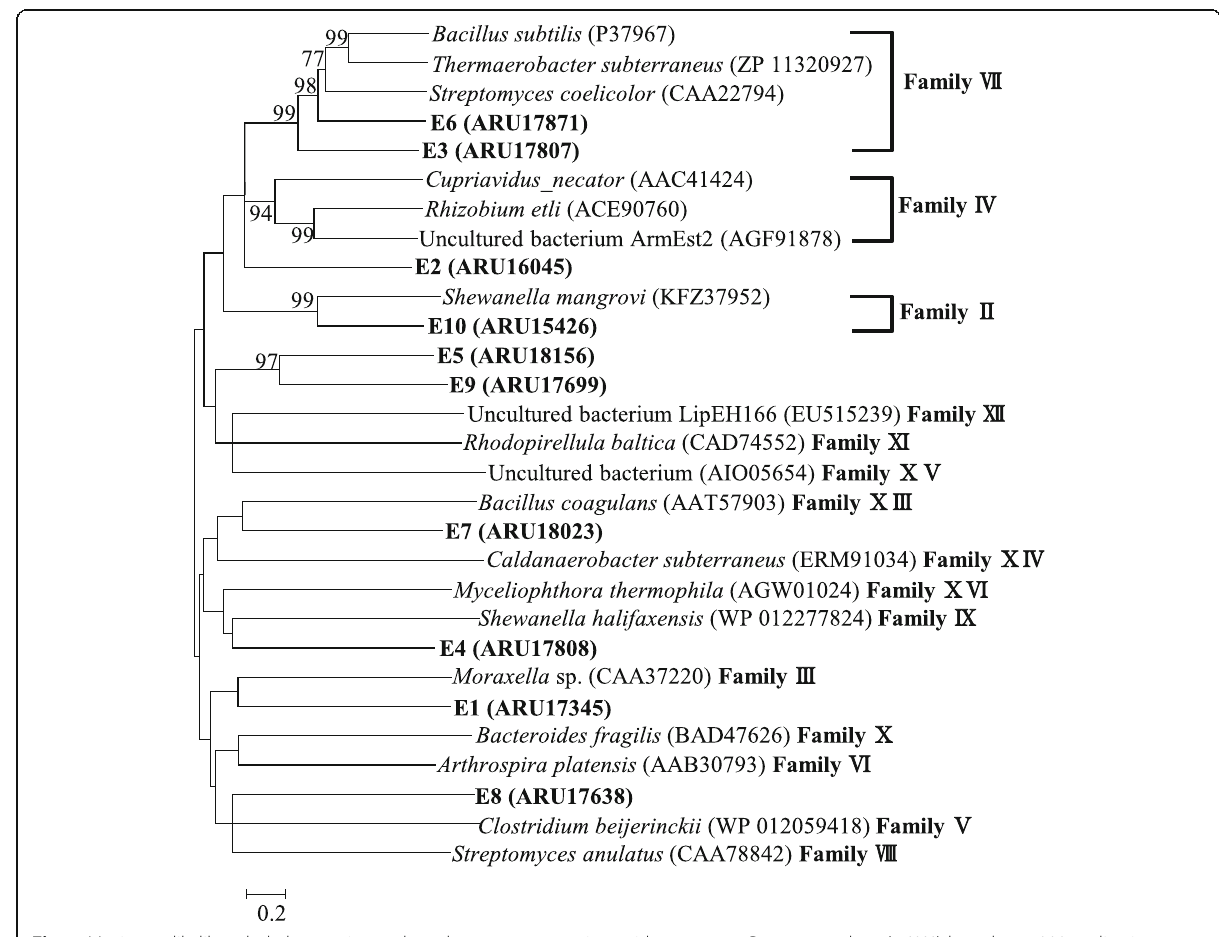
Fig. 4 Maximum-likelihood phylogenetic tree based on esterases amino acid sequences. Bootstrap values (>60%) based on 1000 replications are shown at branch